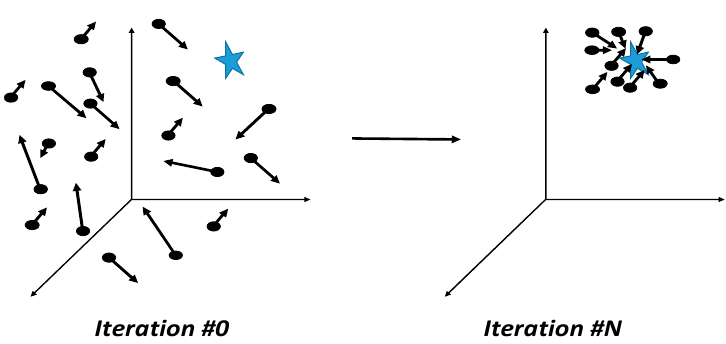
Energies 2017 , 10 , x 9 of 22 Figure 5. Flowchart of the PSO algorithm. Initialization In the initialization process of PSO, the algorithm hires a certain number of particles (N) of the search space. PSO has only two parameters, namely, particles’ position and velocity. Moreover, it is a fast convergent and global solution solver for most scientific and engineering optimization problems. Each particle is assigned to a distinct location represented by (cid:1850) (cid:3036) within the search space. These particles move in a pattern within the search space. Movement Each particle moves from its current location, (cid:1850) (cid:3036)(cid:3038) , to the global optimum position ( (cid:1833) (cid:3029) ) with velocity (cid:1848) (cid:3036)(cid:3038) in the search space. Such movement helps the particle to stochastically explore the entire